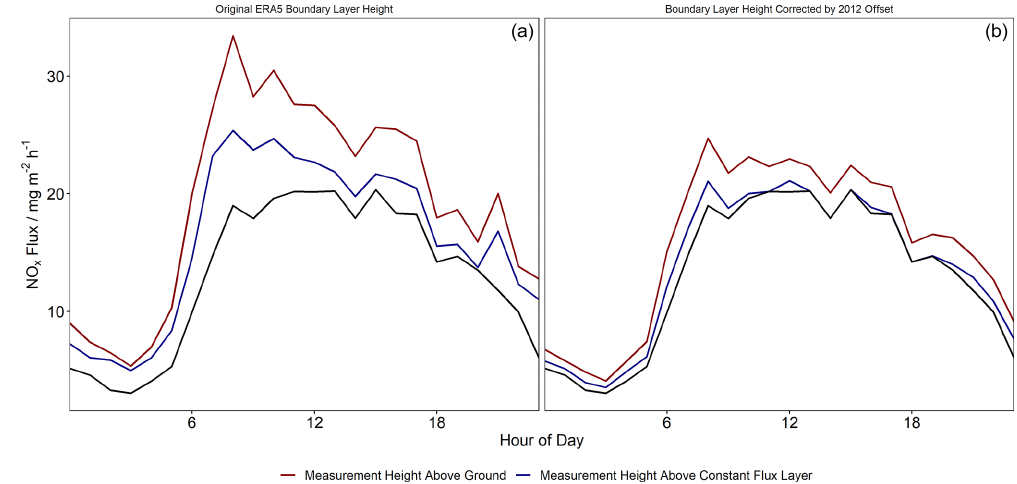
Figure A2. Visualisation of the vertical flux divergence corrections with respect to boundary layer height. (a) Corrected NO x flux against